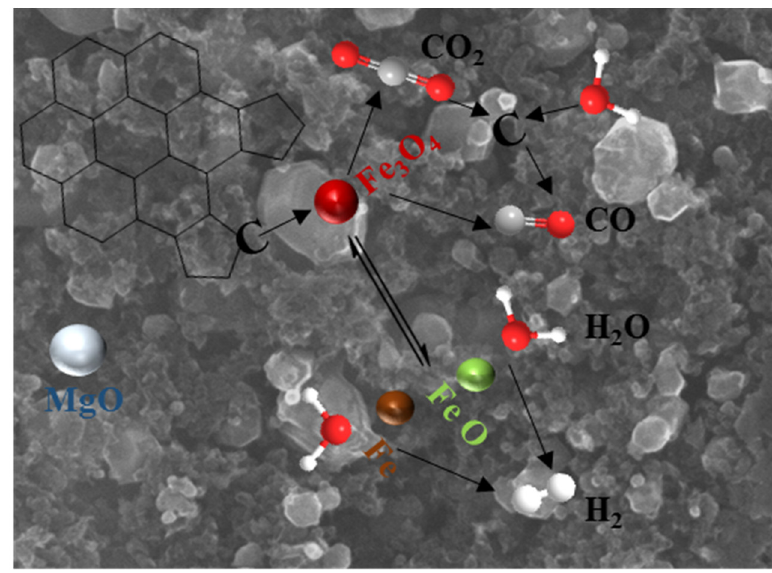
Figure 2. The biochar preparation mechanism.